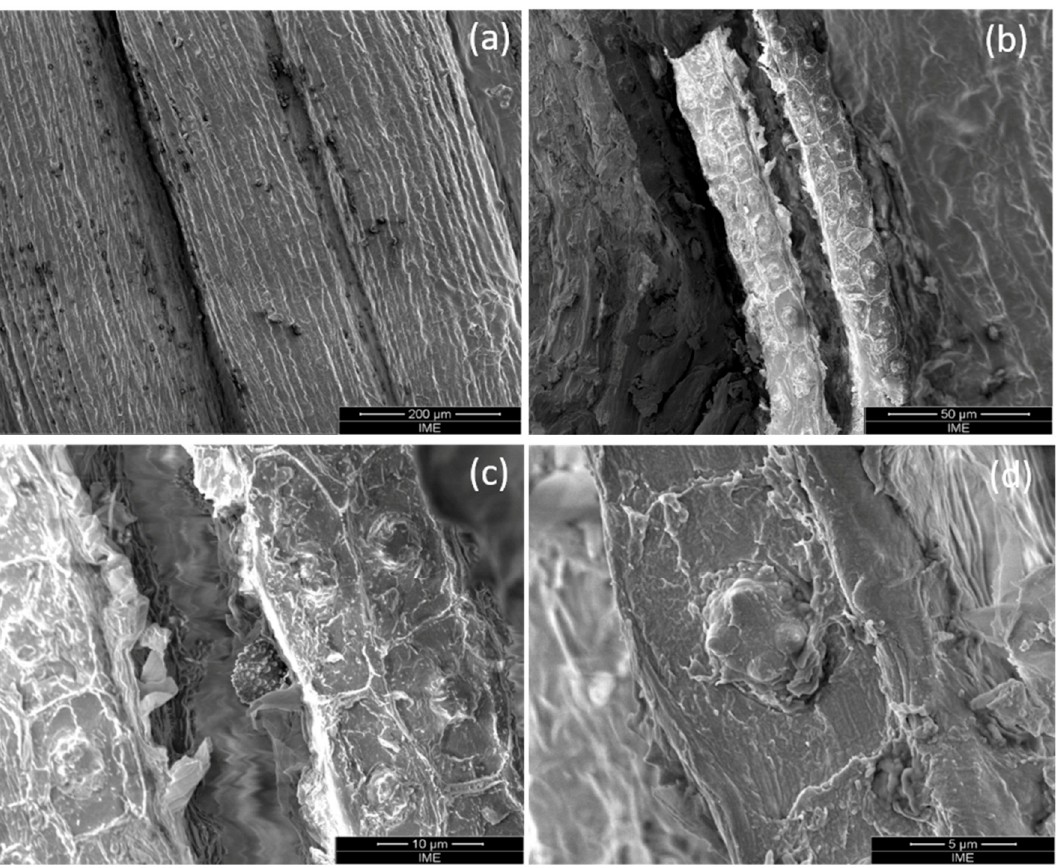
Figure 5. Surface morphology of tucum fiber with increasing magnification ( a ) 400×; ( b ) 1600×; ( c ) 6000×; ( d ) 12000×.